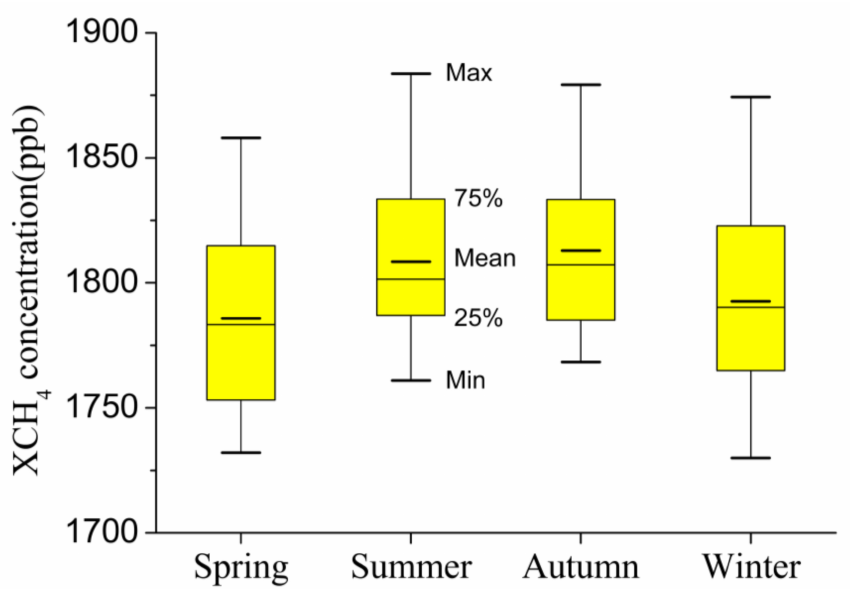
Figure 6. Variation in the mean seasonal XCH 4 concentration over China from 2003 to